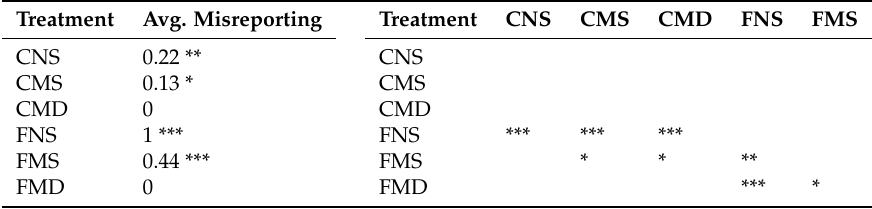
Table A4. Misreporting of Type L Patients across experimental conditions. Treatment